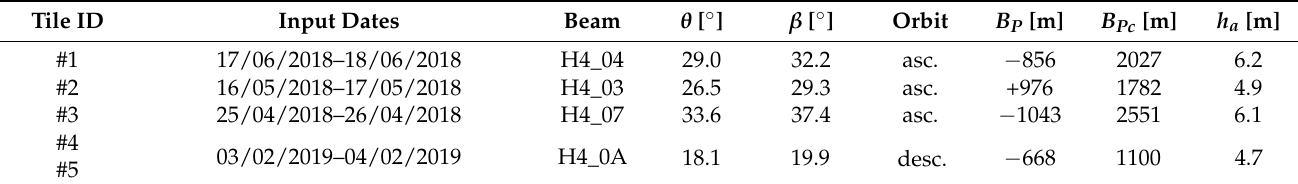
Table 1. COSMO-SkyMed StripMap HIMAGE scenes used for the InSAR processing and generation of the five DEM products. Notation: asc.: ascending; desc.: descending; θ : look angle at scene center; β : incidence angle at scene center; B P : perpendicular baseline; B Pc : critical perpendicular baseline for flat terrain; h a : height ambiguity; #: tile ID